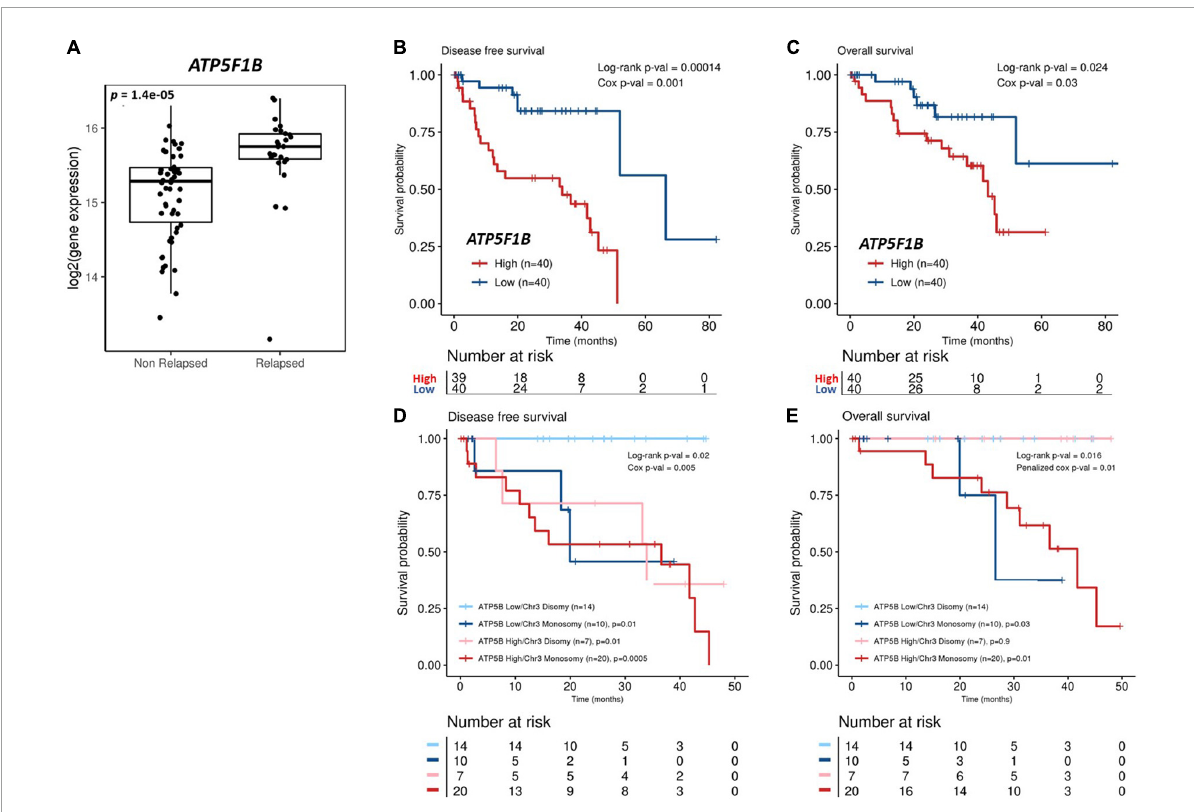
FIGURE7 Analysis of ATP5F1B expression and UM patient outcomes from The Cancer Genome Atlas (TCGA). (A) Patients from the TCGA-UM dataset were categorized into those that received a diagnosis of primary UM, but their disease had not progressed (non-relapsed) vs. those who had developed recurrent disease (relapsed). ATP5F1B expression in primary UM is significantly higher ( p < 0.001) in UM patients presenting with relapsed disease. Statistical analysis was carried out using a non-parametric Wilcoxon test. Kaplan–Meier survival curves demonstrate a statistically significant relationship between high (red) ATP5F1B expression and disease-free survival (B) ( n = 80; Log-rank; p = 0.00014) or overall survival (C) ( n = 80; Log-rank; p = 0.024) in UM patients. Low ATP5F1B expression is shown in blue (B,C) . Monosomy 3 is a strong prognostic indicator of overall survival, irrespective of ATP5F1B expression (E) . There is a significant difference in disease free survival in disomy 3 patients combined with low ATP5F1B expression compared to those with monosomy 3 and low ATP5F1B ( p = 0.01), those with disomy 3 and high ATP5F1B expression ( p = 0.01), and those with monosomy 3 and high ATP5F1B expression ( p = 0.0005) (D) . Both Log-rank p -values and Cox p -values were calculated and are